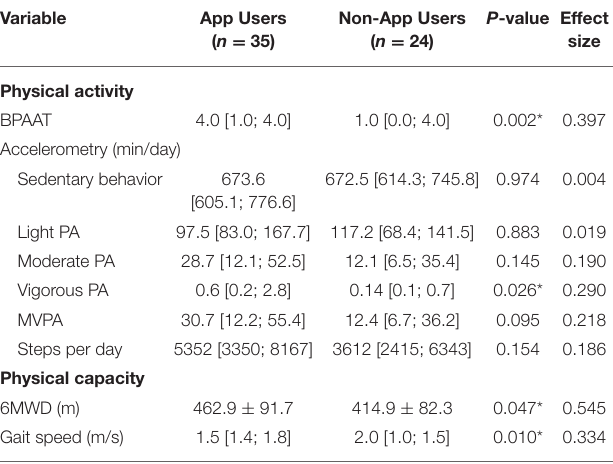
TABLE 2 | Physical activity and physical capacity of App Users and Non-App Users. Variable